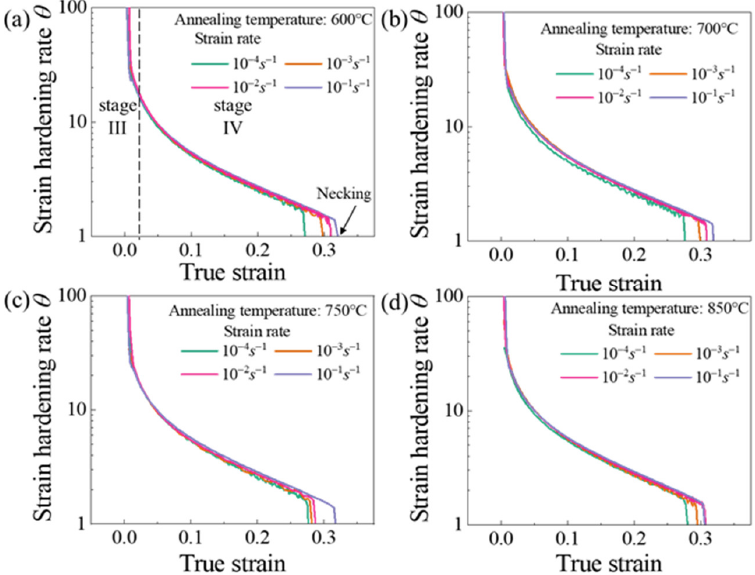
Figure 6. Normalized strain hardening rate ( θ ) vs. true strain of specimens with different annealing conditions at various strain rates: ( a ) 600 °C, ( b ) 700 °C, ( c ) 750 °C, and ( d ) 850 °C.